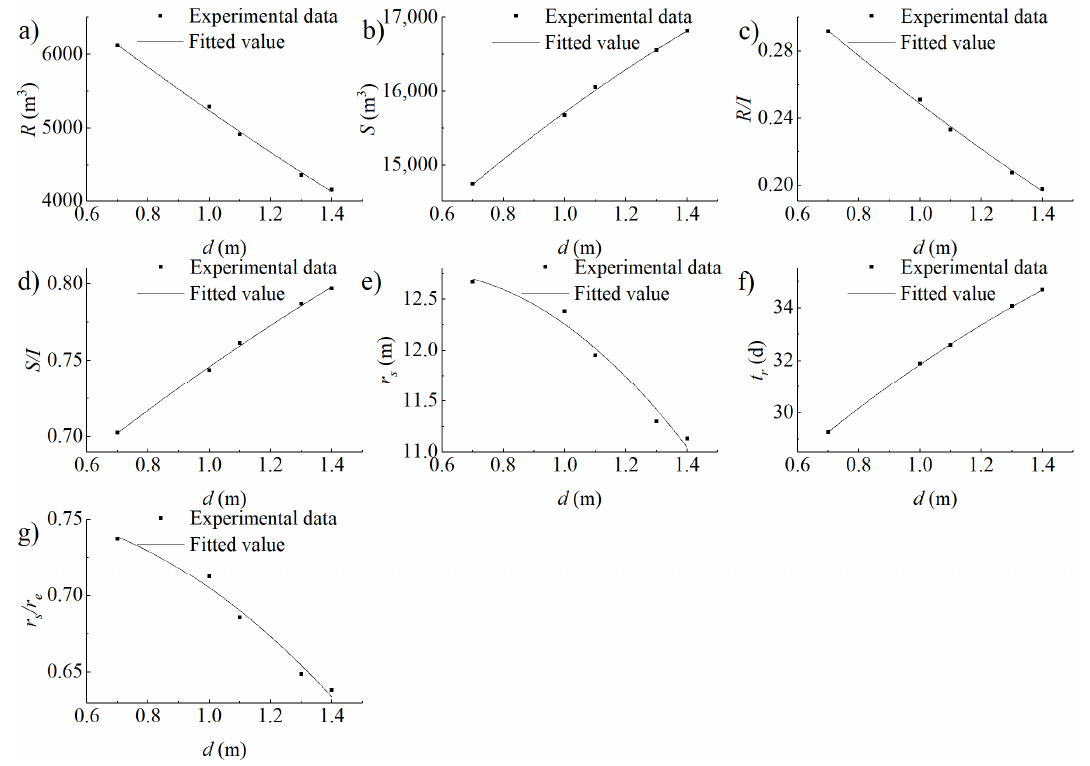
Figure 16. The variations with an increment in d when the depth is 30 m. (( a ) variation of R; ( b ) variation of S; ( c ) variation of R/I; ( d ) variation of S/I; ( e ) variation of r s ; ( f ) variation of t r ; ( g ) variation of r s /r e .).